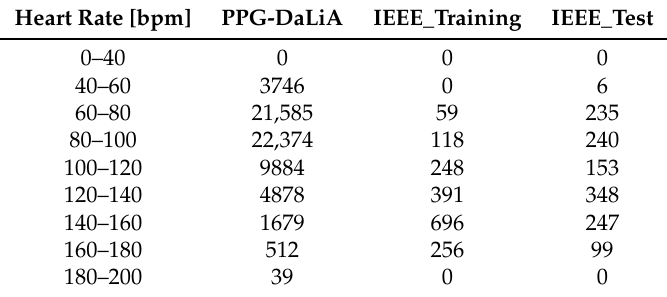
Table 2. Comparison of the datasets PPG-DaLiA , IEEE_Training , and IEEE_Test : Distribution of samples (8-s segments) with respect to heart rate ground truth.